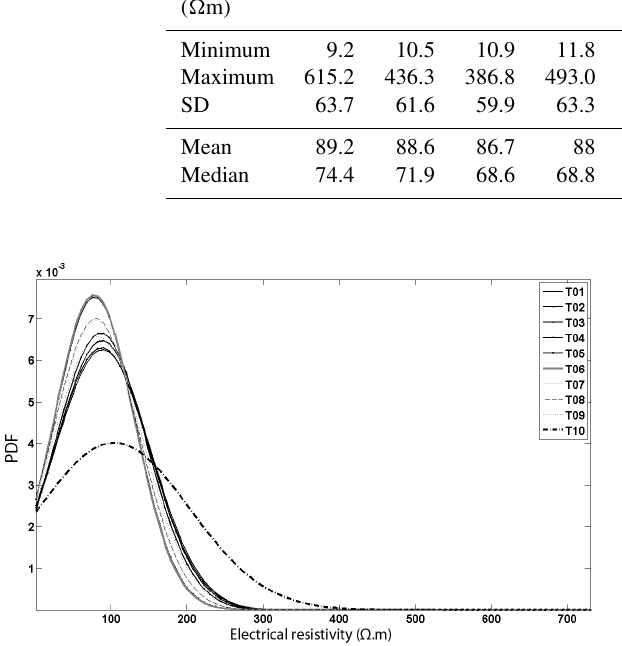
Figure 3. Probability density functions (PDF) estimated from elec- trical resistivity measurements of the entire 2-D section at each date of electrical resistivity tomography. Curves were fitted with a Gaus- sian